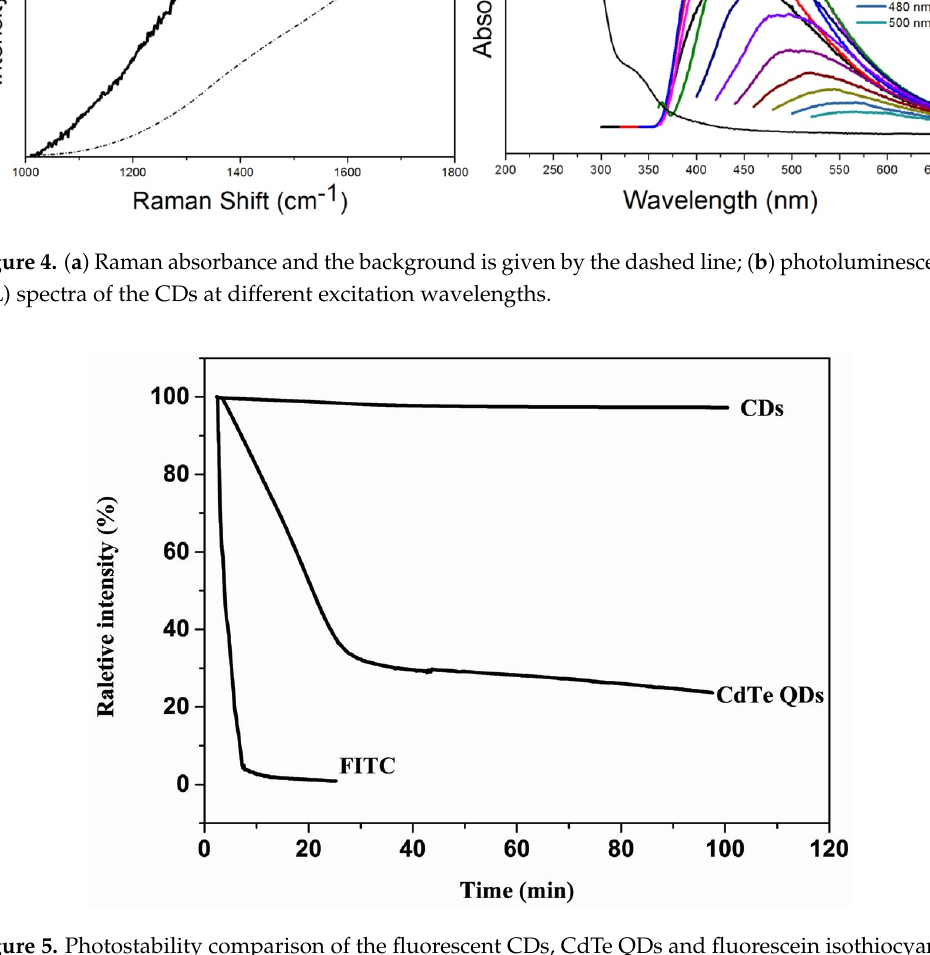
Figure 5. Photostability comparison of the fluorescent CDs, CdTe QDs and fluorescein isothiocyanate (FITC) in a fluorescence spectrophotometer with a 150 W Xe lamp under 360 nm excitation.